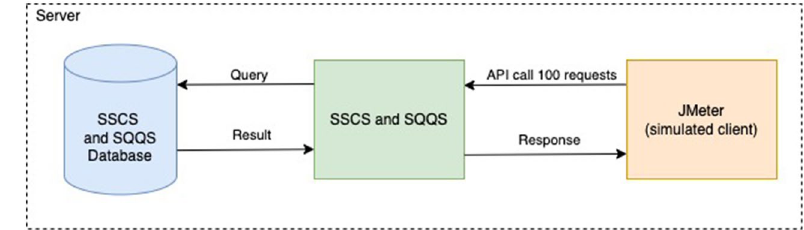
Fig. 4 Database read evaluation topology on the proposed